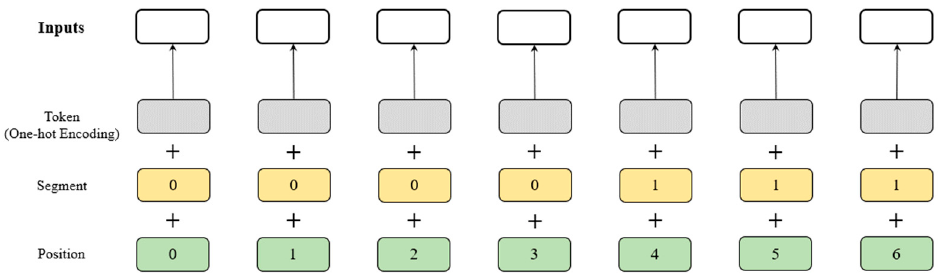
Figure 3. Examples of features and structures used as inputs of